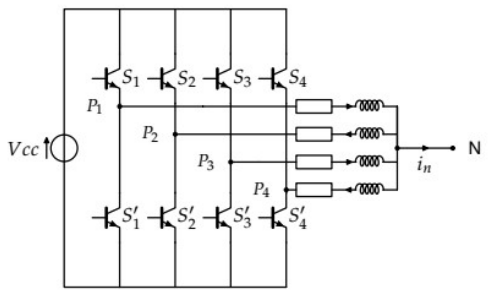
Figure 6. Equivalent circuit of the four-phase inverter model.